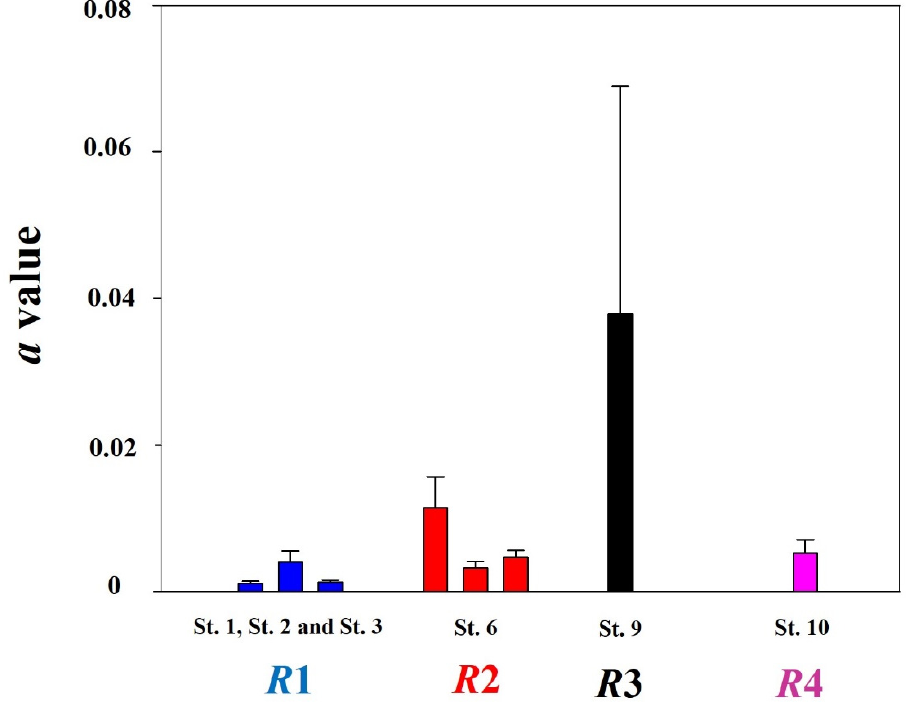
Figure 2. Regional a values for chum salmon ( Oncorhynchus keta ) individuals that migrated to South Korea from 2018 to 2020. The a value showed the greatest value on the R 3 region, while the R 1 region showed the smallest value. For the a values, we calculated them using datasets in the year 2018 for R 1 regions. Datasets from 2018 to 2020 were used to calculate the a values in R 2, while datasets in 2020 were used for R 3 and R 4 regions (n = 422 for St. 1; 11 for St. 2; 18 for St. 3; 258 for St. 6 in 2018, 566 in 2019, and 883 in 2020. For St. 9 and St. 10, the ‘n’ is 43 and 291, respectively).